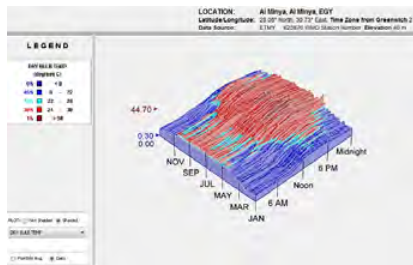
Figure 2. Daily Dry Bulb Temp showing the hottest and coldest